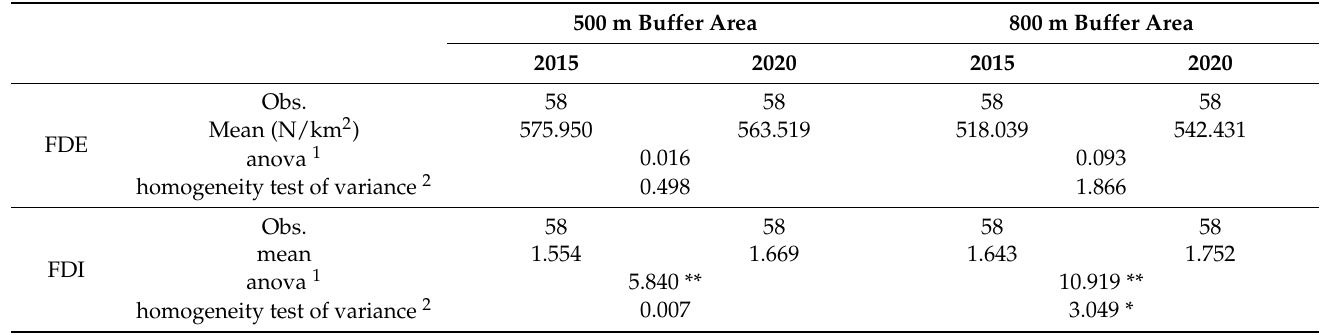
Table 5. Variation of functional intensity of surrounding areas of main urban village renovations between 2015 and